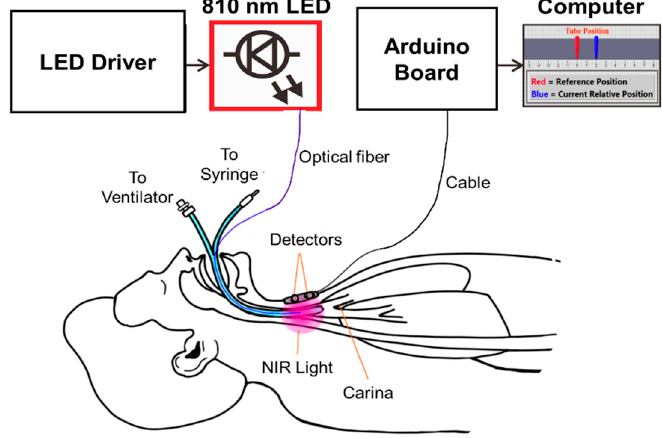
Figure 1. Principle schematics of the optical sensor (Opt-ETT) system and the intended use for endotracheal tube (ETT) monitoring.